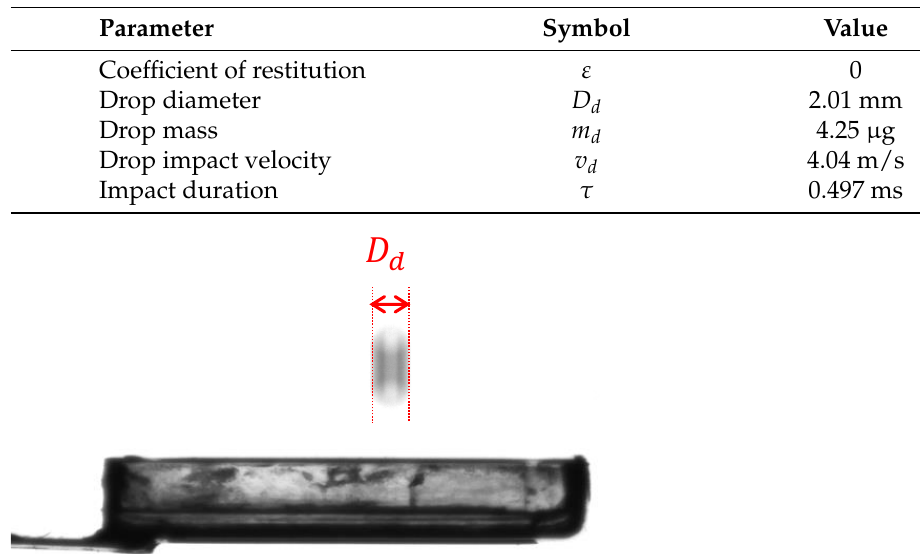
Table 2. Parameters for the computation of the impact force acting on the dry spoon.